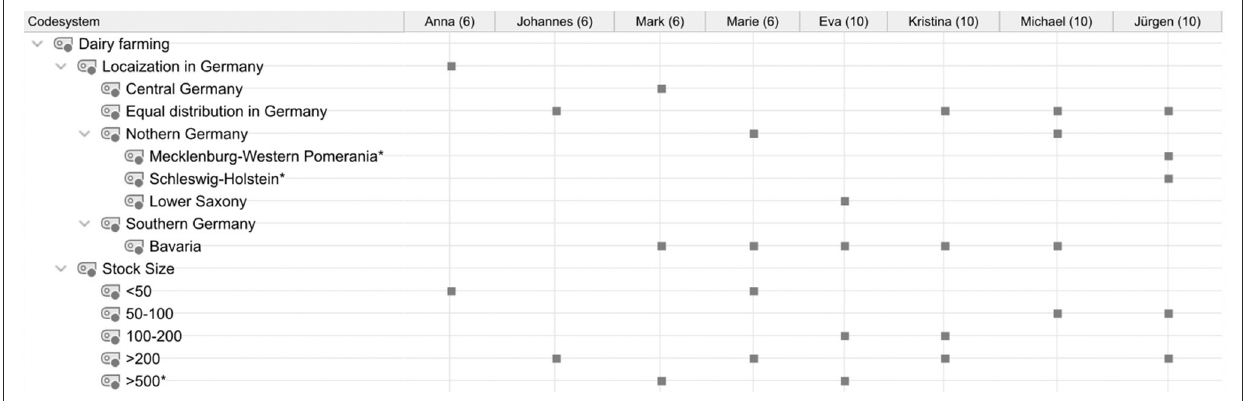
FIGURE4 Overview of the students’ statements on the localization of dairy farms in Germany and their stock sizes. *Inductively coded categories. The marks by the categories indicate that they were named by the